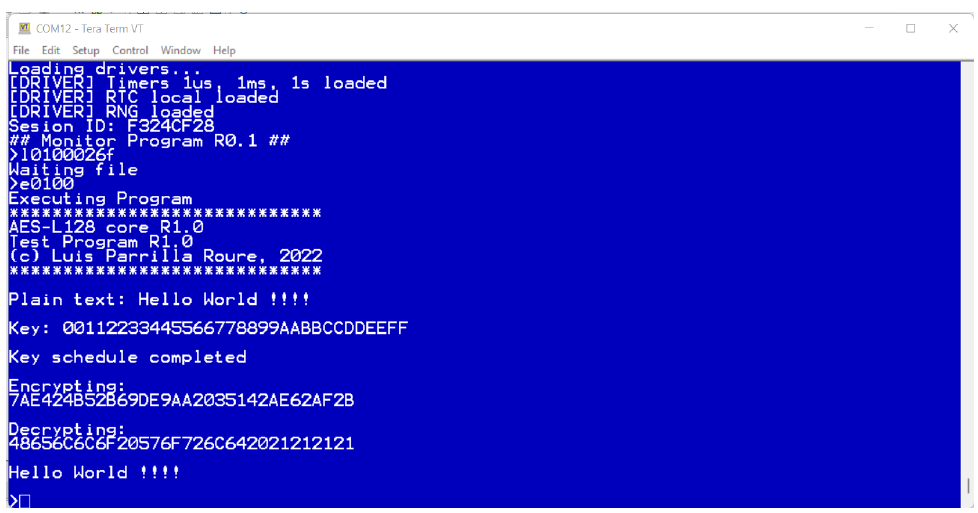
Figure 14. Experimental setup for minimal Dracon extended with two UARTs, Bluetooth connectivity and cryptographic support for secure measurements with a DHT11 sensor.